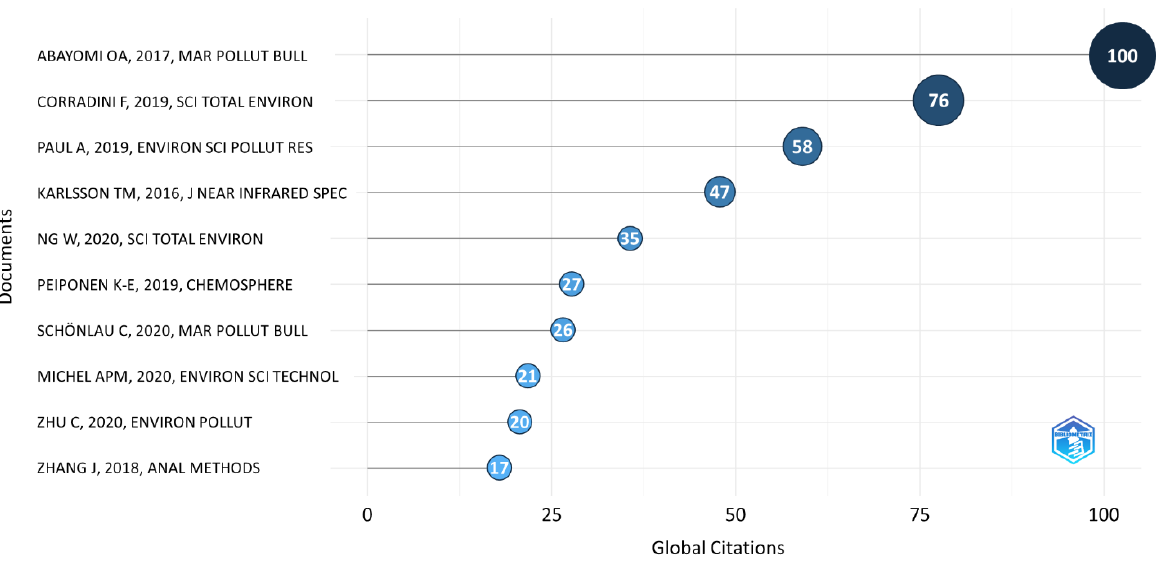
Figure 6. Top 10 most globally cited documents with number of citations for NIR-related lit- erature [10–12,50–56]. The figure was generated using the open-source tool Biblioshiny for Bib- liometrix